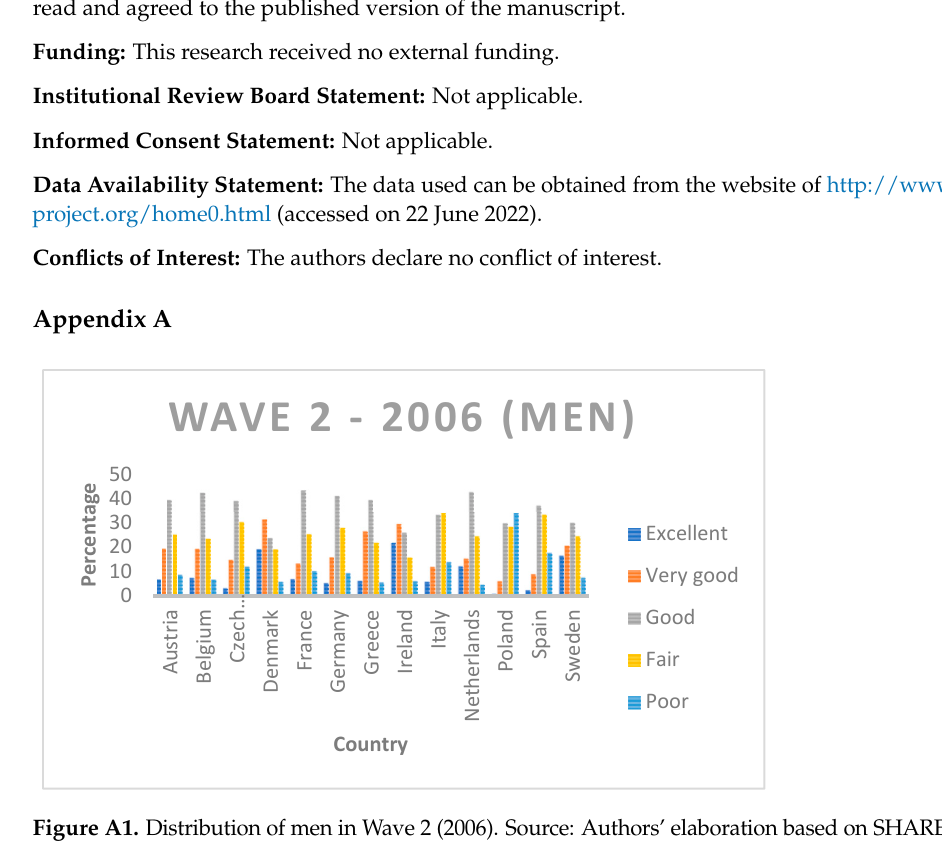
. Figure A2. Distribution of women in Wave 2 (2006). Source: Authors’ elaboration based on SHARE (2021). Figure A3. Distribution of men in Wave 4 (2010). Source: Authors’ elaboration based on SHARE (2021).